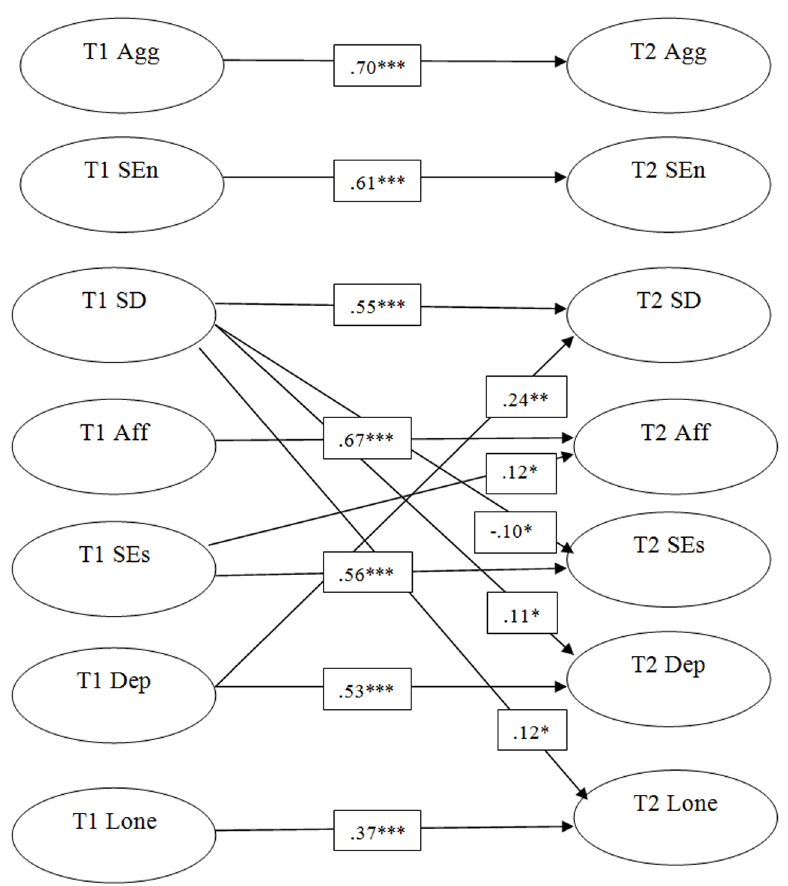
Figure 1. Schematic of structural model for psychosocial adjustment and humor styles (omitting error terms, indicators for latent variables and covariance paths). Note. Only significant paths shown. Stability coefficients appear in the middle of the diagram. * p < .05. ** p <